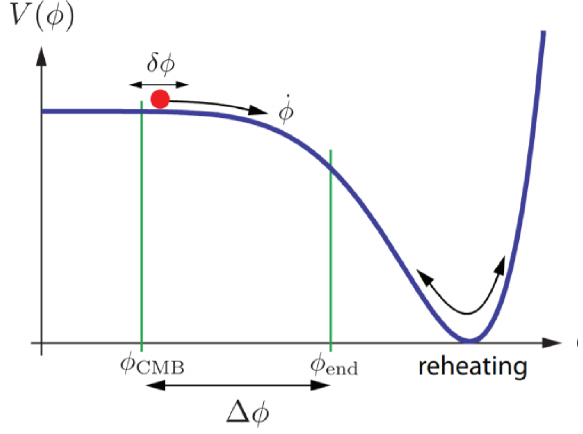
Figure 19. How inflation ends-slow roll